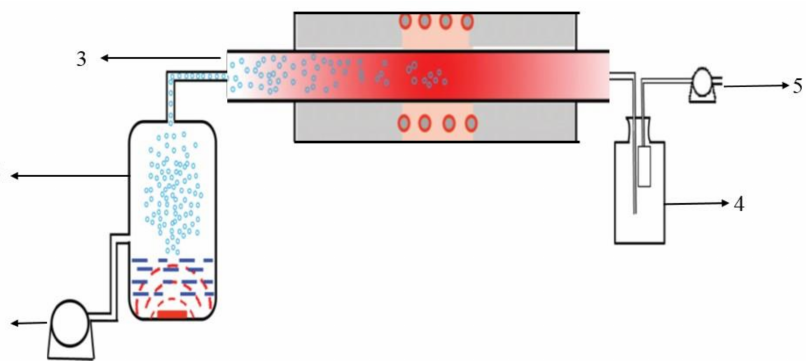
Figure 1. Schematic diagram of spray pyrolysis equipment. ( 1 ) Air compressor; ( 2 ) Liquid storage bottle; ( 3 ) Reaction furnace; ( 4 ) Collection bottle; ( 5 ) Recovery